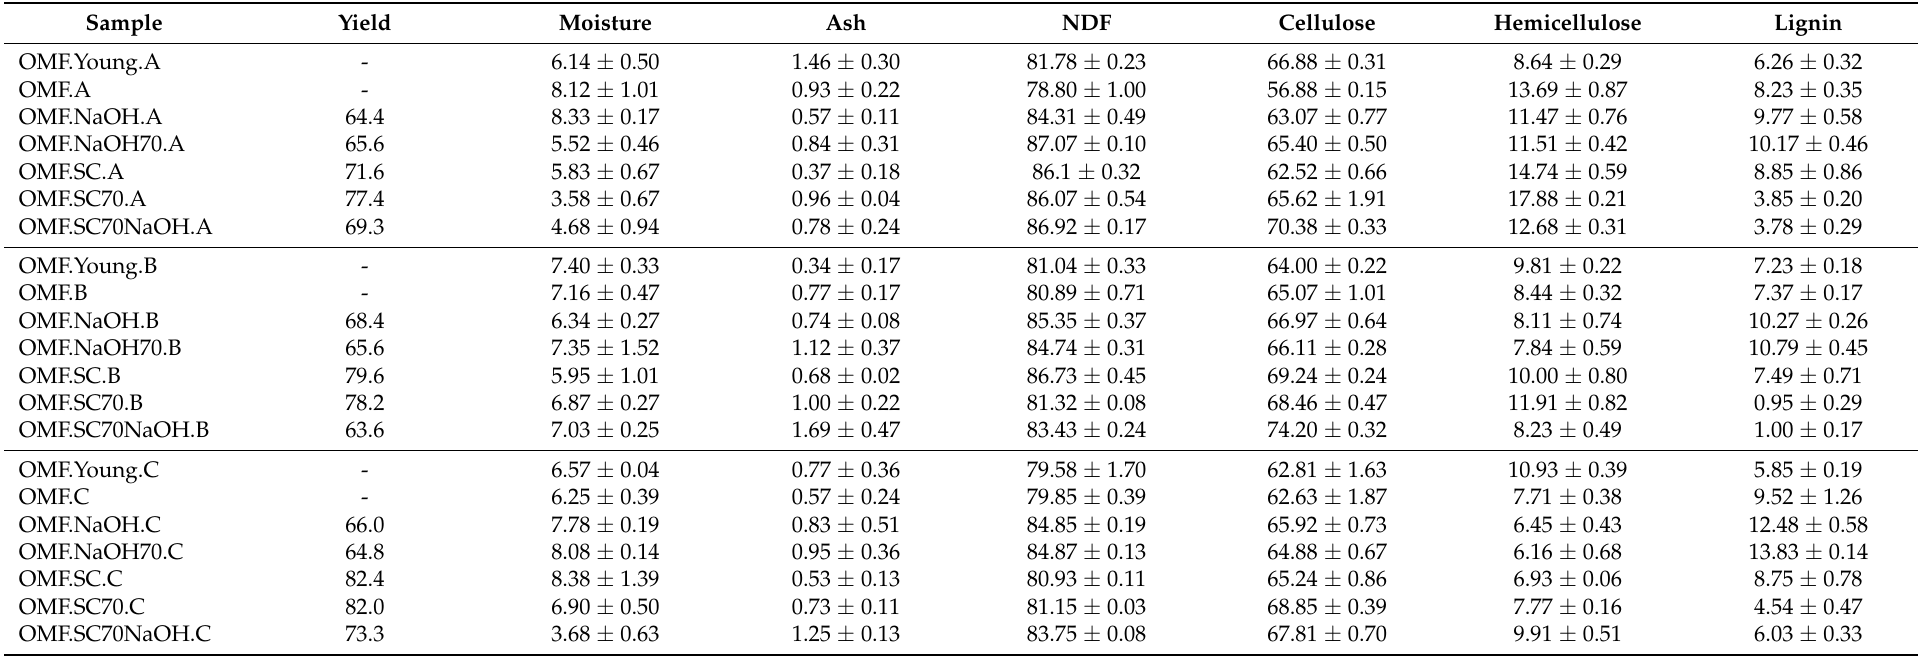
Table 5. Composition of Opuntia fibre (% wt in dry